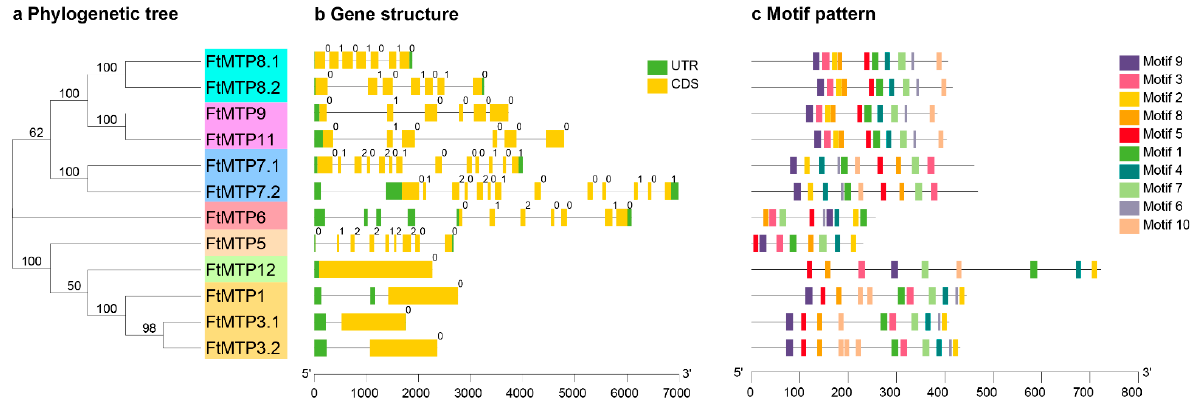
Figure 2. Phylogenetic tree, gene structure, and motif pattern analysis of FtMTPs . ( a ) the neighbor-joining phylogenetic tree was constructed with MEGA 7.0 using FtMTP amino acid sequences with 1000 replications bootstrap; ( b ) exon-intron structure of FtMTP genes where yellow boxes represented the exons, the black lines represented the introns, and the green boxes represented the untranslated regions (UTRs), with size scales detailed at the bottom; ( c ) the motif patterns of FtMTP proteins using ten conserved motifs (Supplementary Figure S1) are represented by the unique color mentioned in the legend on the top lift, with size scales detailed at the bottom.